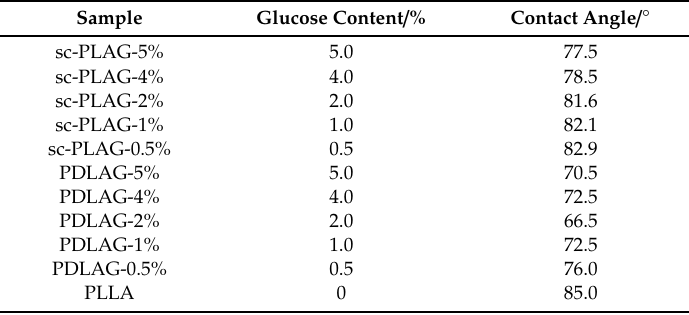
Table 4. Water contact angles of PLLA and sc-PLAG